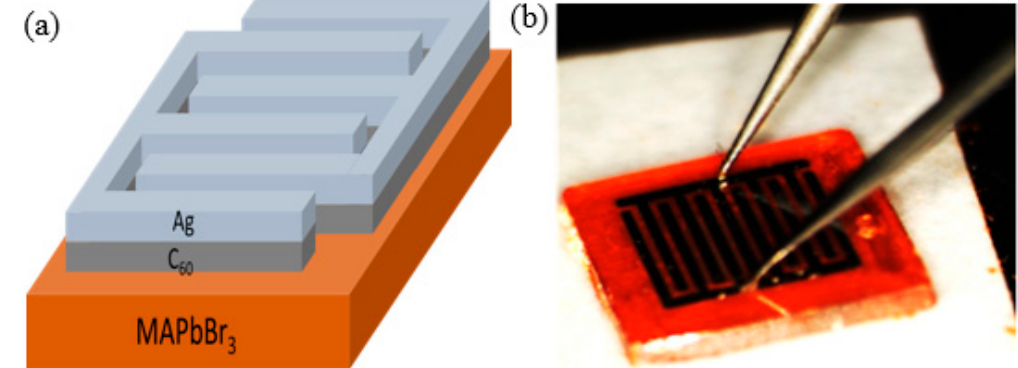
Figure 8. ( a ) Metal–semiconductor–metal (MSM) structure of the MAPbBr3 crystal photodetector. ( b ) Photograph of a MAPbBr 3 crystal photodetector.